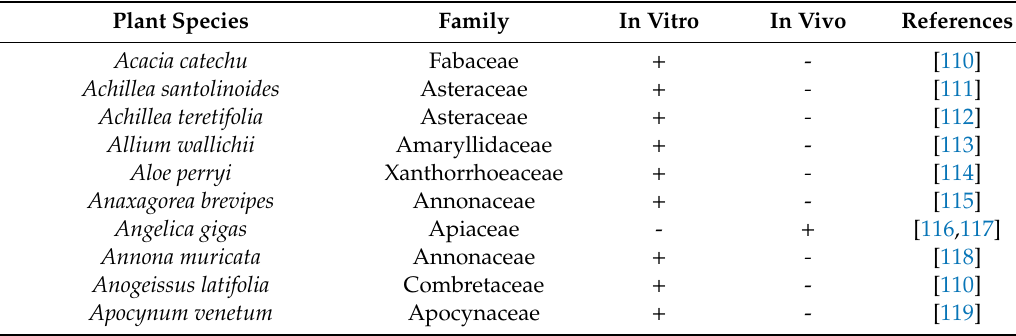
Table 3. Medicinal plants with anti-prostate cancer e ff